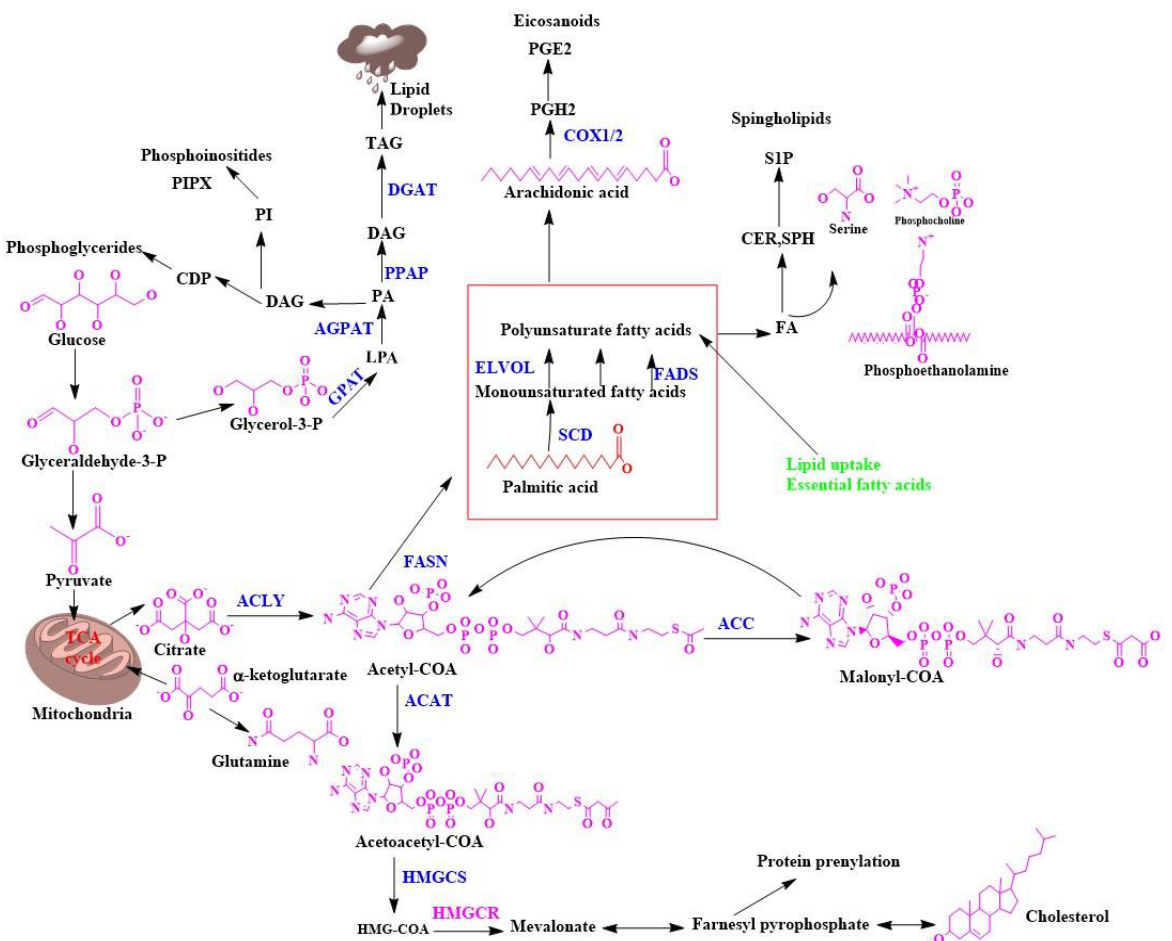
Figure 2. Biosynthesis of lipids in biological membranes.